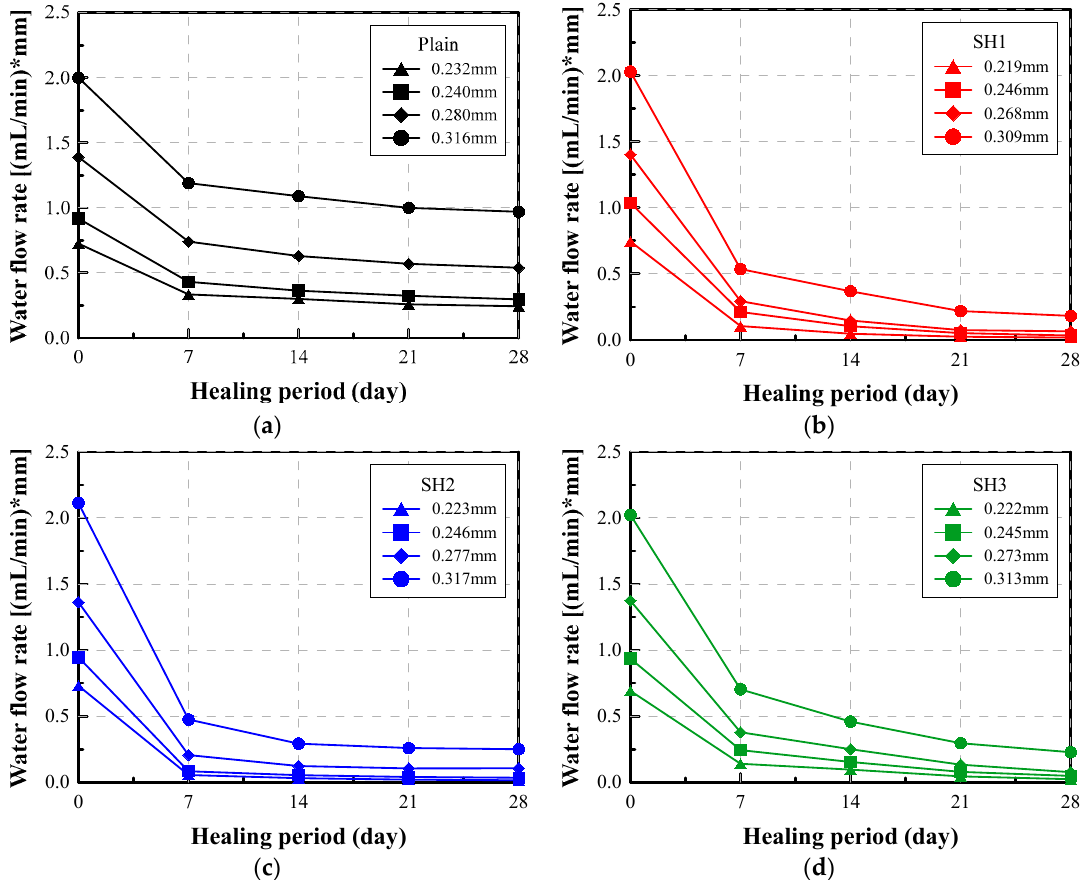
Figure 7. Water flow rate vs. healing period of selected specimens: ( a ) Plain, ( b ) SH1, ( c ) SH2, ( d ). SH3 .